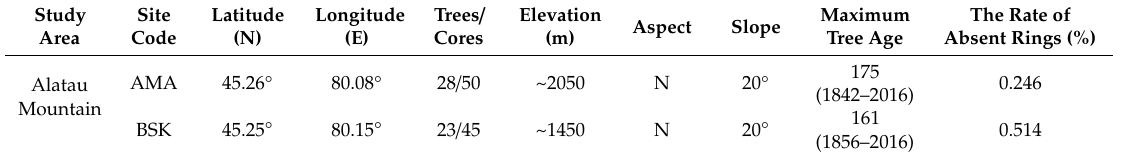
Table 1. Information of the two sampling sites in the Alatau Mountains, Central Asia.